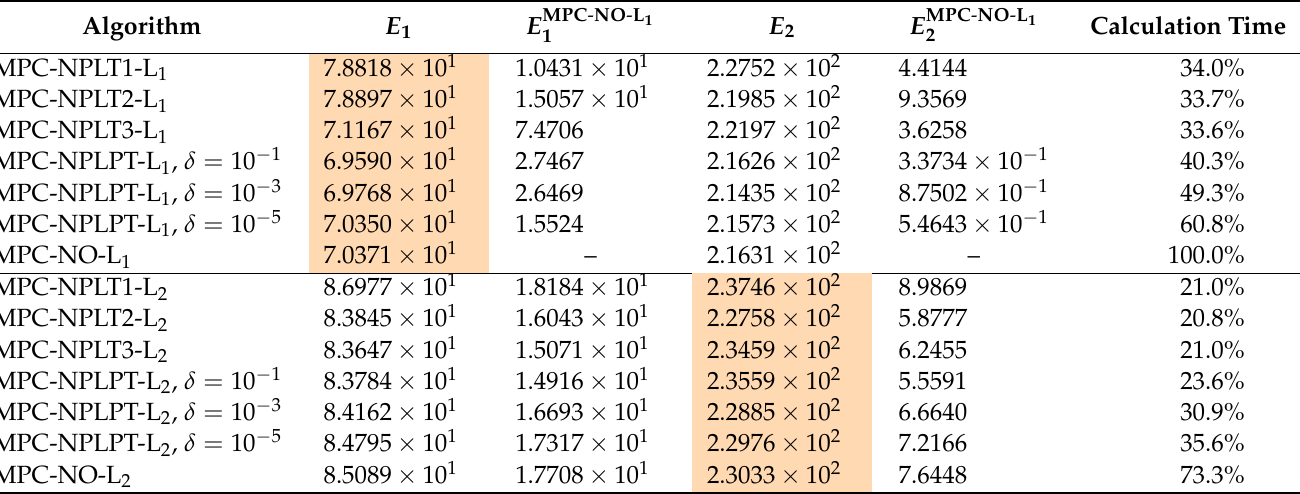
Table 1. Simulation results: the values of the control quality criteria and the scaled calculation time, the cost function type corresponding to that minimised in MPC is denoted in color; in all cases λ =